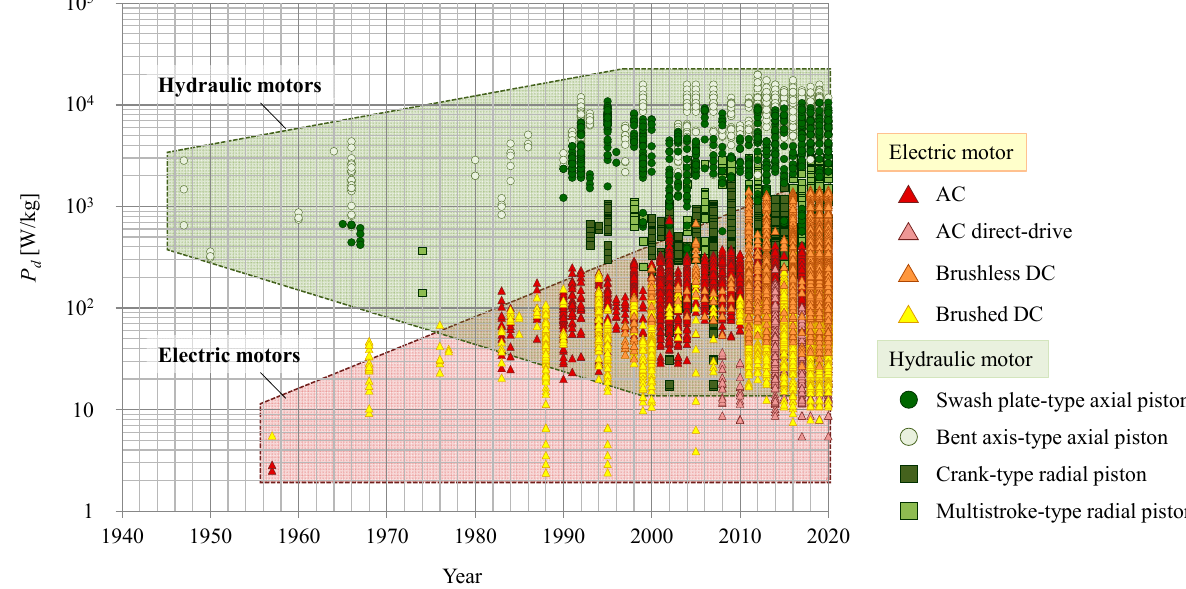
Figure 1. Transition of power density in electric and hydraulic motors.